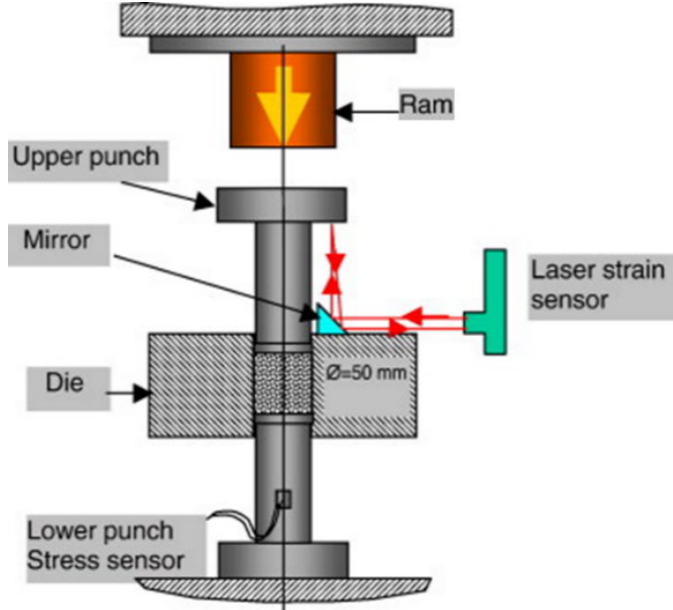
Figure 10. Schematic diagram of high-velocity compaction [129].